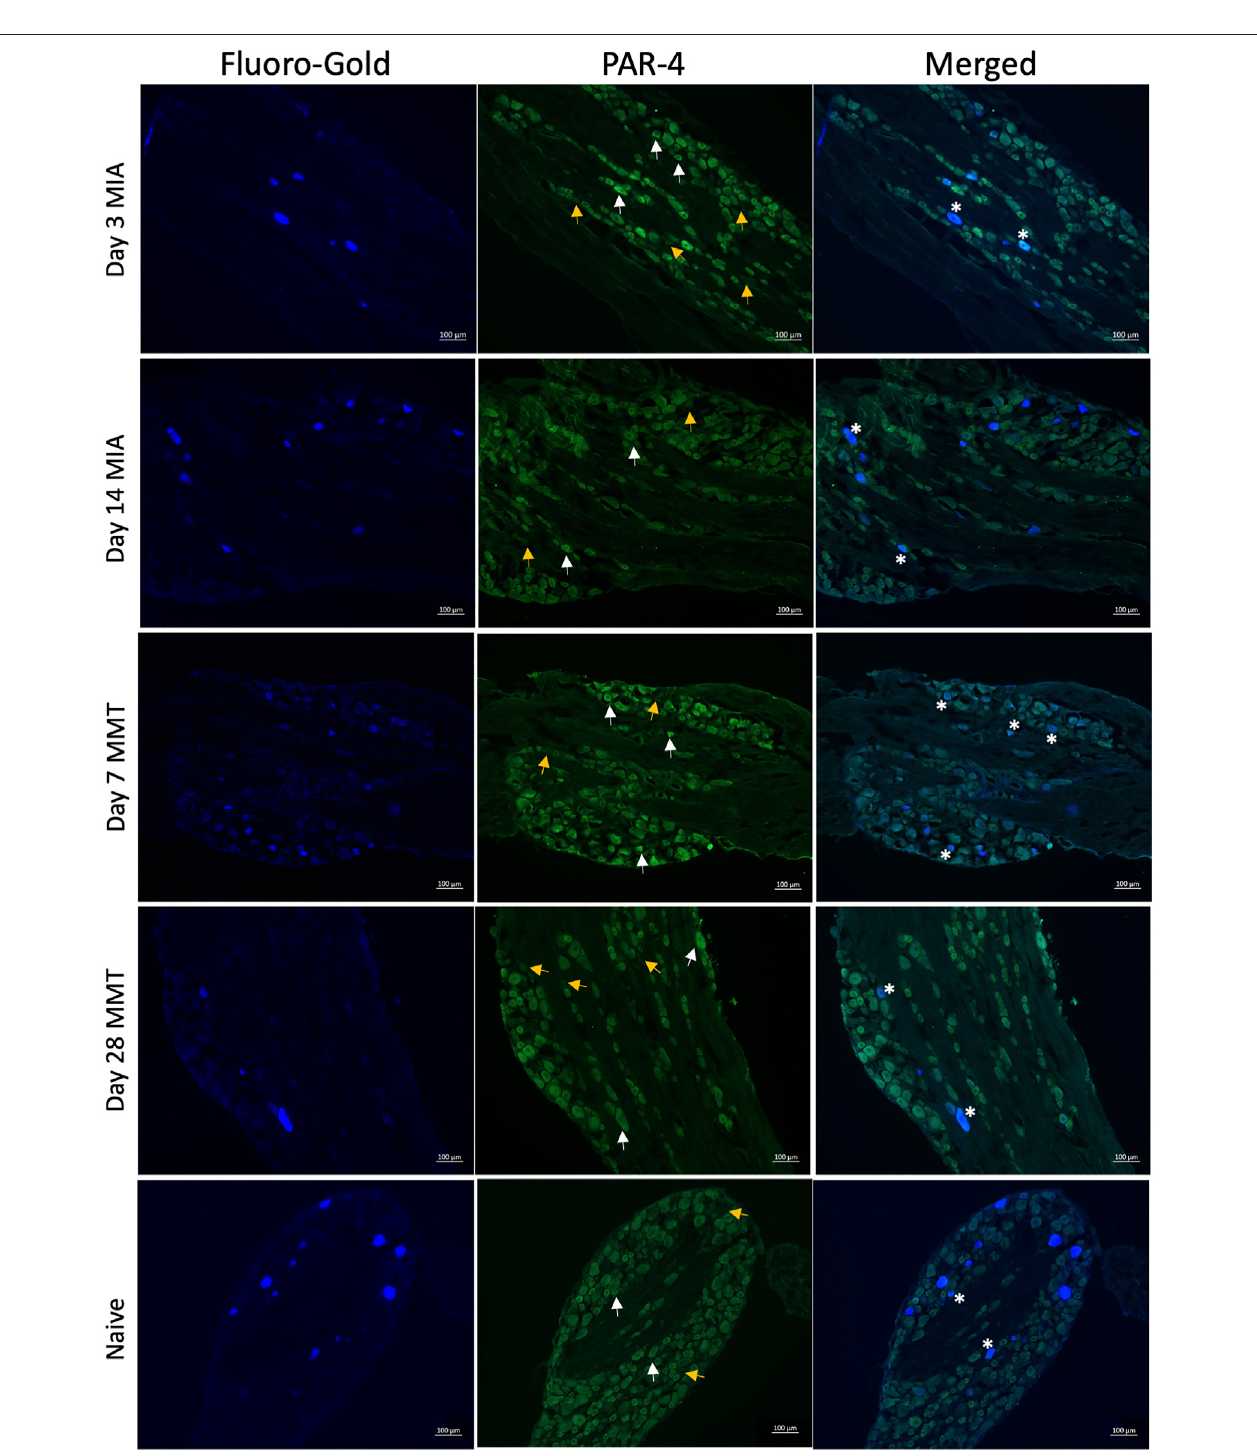
FIGURE 3| PAR4 Expression in Joint DRG Neurons. Representative photomicrographs ofFluoro-gold (FG) traced jointneurons that PAR4. White arrows indicate positive expression of PAR4 and yellow arrows indicate a lack of expression, asterisks represent coexpression.